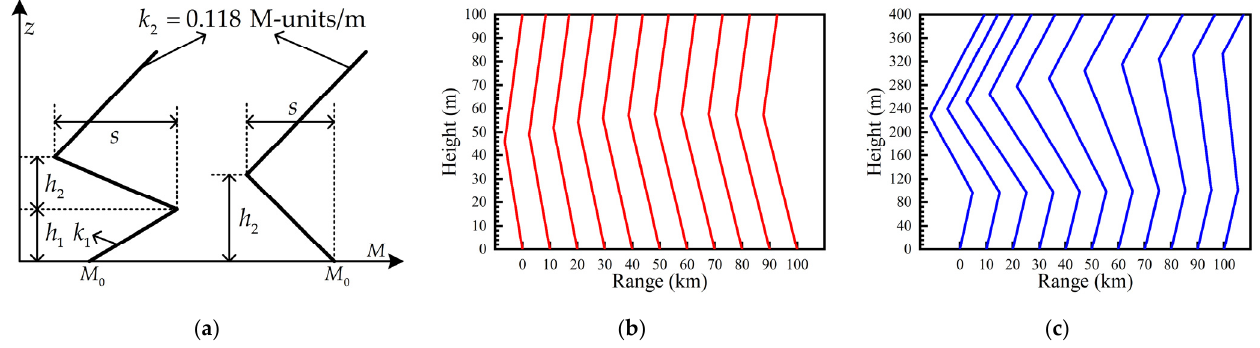
Figure 4. Modified refractivity profiles of surface ducts: ( a ) parameterized models; ( b ) horizontally inhomogeneous surface duct without a base layer; and ( c ) horizontally inhomogeneous surface duct with a base layer.